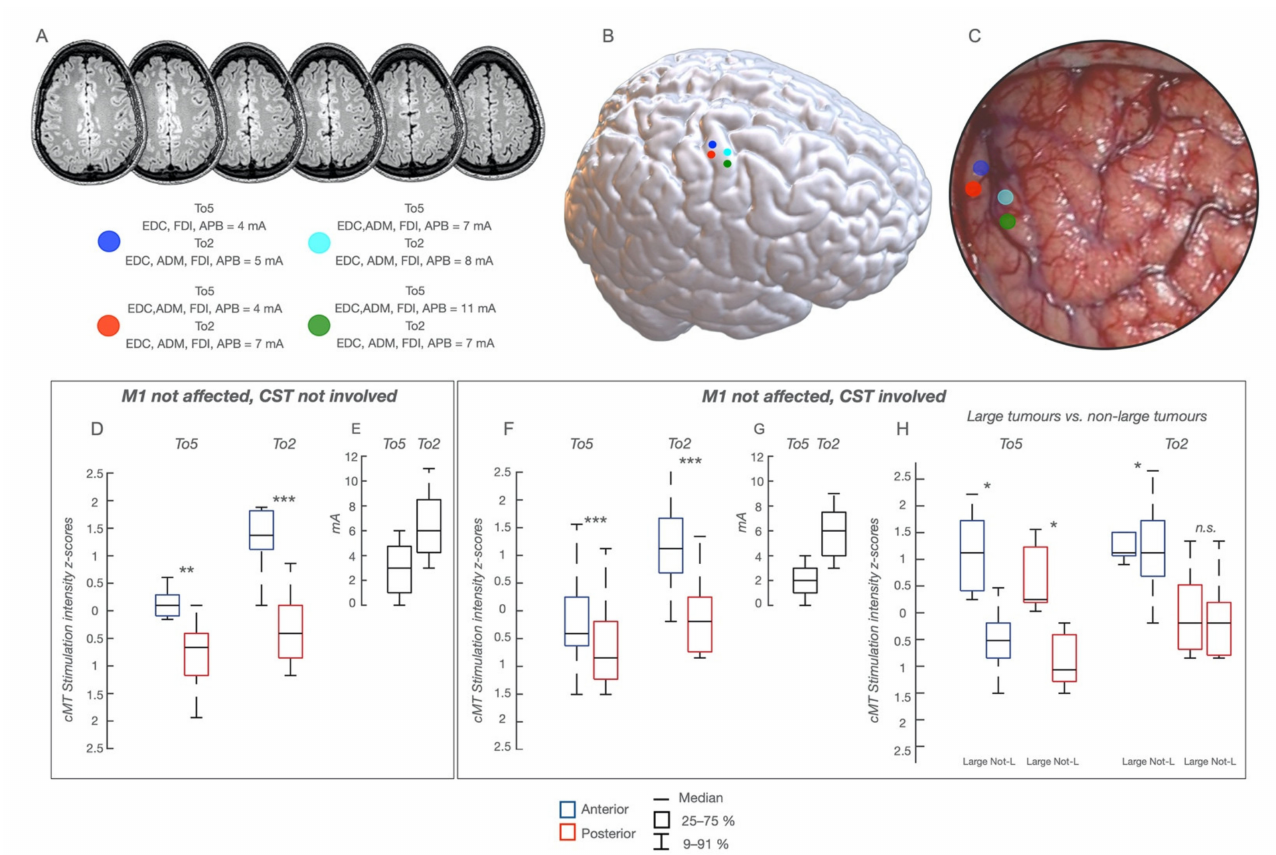
Figure 2. Functional Map in patients with M1 intact and CST not involved or involved at variable extent, whose cortical functional map is presented in a representative patient with a glioma involving the non-dominant hemisphere; the lesion is visible in ( A ), sequential axial FLAIR images and a poorly defined mass (low-grade) involving the pre-SMA region. The sites of HF-To5 and HF-To2 stimulation in the hand-knob region are visible as colored dots superimposed to the NMI space ( B ) and to the intraoperative field picture ( C ). For each dot, the cMT (quantitative parameter) at HF-To5 and HF-To2 and the pattern of muscle activated (qualitative parameters) are reported. ( D ) Comparison of cMT obtained with HF-To5 and HF-To2 for the stimulation of the anterior and posterior region of the hand-knob area in the 9 patients with M1 and CST not involved; cMT are expressed as 25–75% median (rectangle) and 9–91% (edge of the box), along with the delta ( E ); * p < 0.5; ** p < 0.01; *** p < 0.001. ( F ) Comparison of cMT obtained with HF-To5 and HF-To2 stimulation of the anterior and posterior region of the hand-knob area, in the 28 patients with M1 intact and the CST involved; cMT are expressed as 25–75% median (rectangle) and 9–91% (edge of the box), along with the delta ( G ); * p < 0.5; ** p < 0.01; *** p < 0.001. ( H ) Comparison of cMT at the anterior and posterior borders of the hand-knob area in the 5 patients of the previous group harboring a large tumor and in the remaining 23 patients. The cMT are higher in the first sub-group of patients (large tumors) with HF-To5 but not with